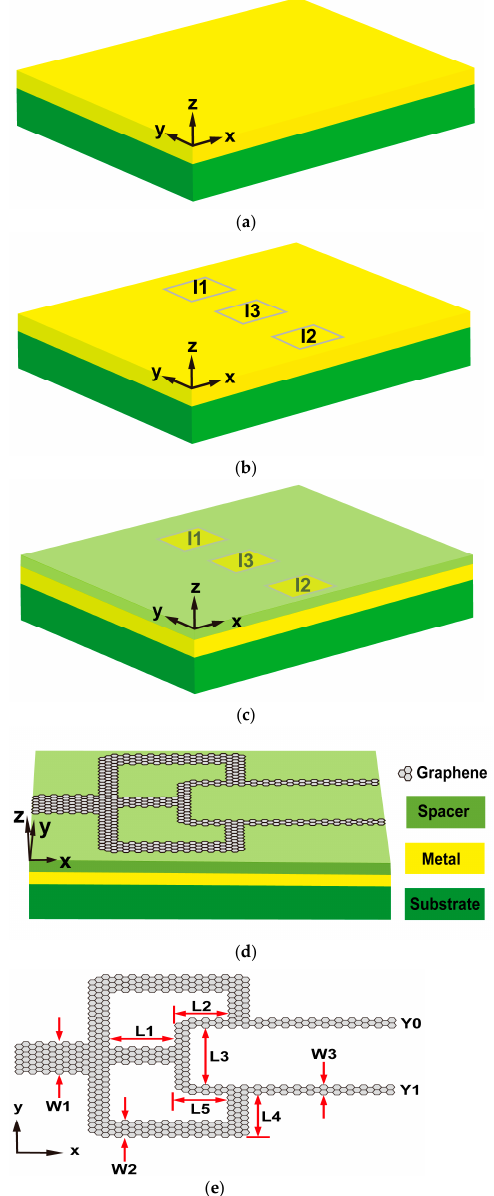
Figure 5. ( a ) Deposition of the metal layer on the dielectric substrate. ( b ) Process of patterning the selected contact electrodes to form the input electrode. ( c ) Deposition of the spacer layer on the patterned metal layer. ( d ) Transfer of graphene nanoribbons on top of the spacer layer and realization of the proposed 4×2 encoder. ( e ) Top view of the graphene waveguide. The geometric parameters are shown in Table 1. The dimensions are not to scale.